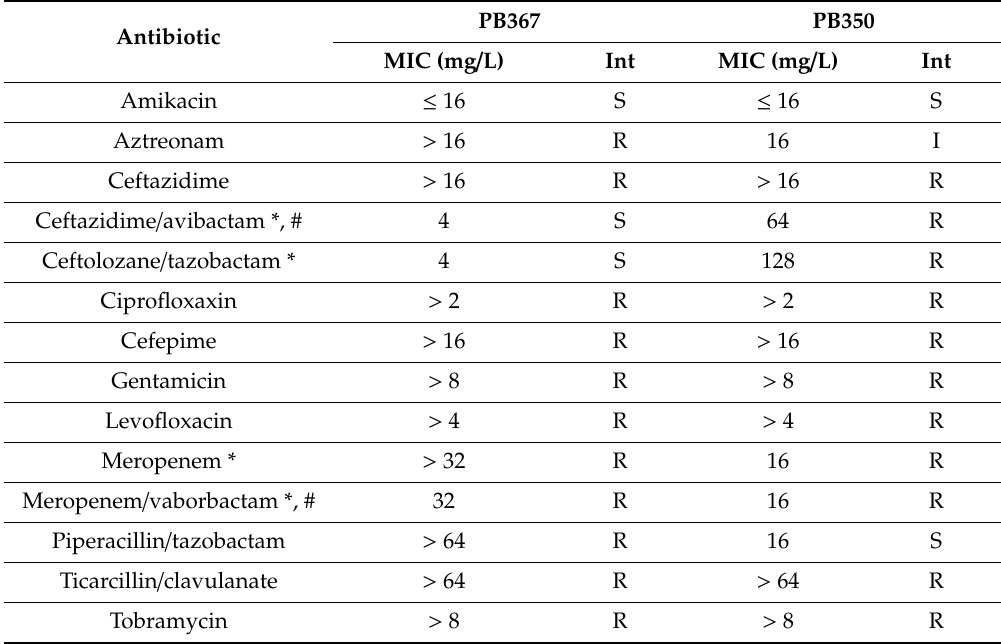
Table 1. Antibiotic characteristics of two P. aeruginosa isogenic isolates from the same patient.